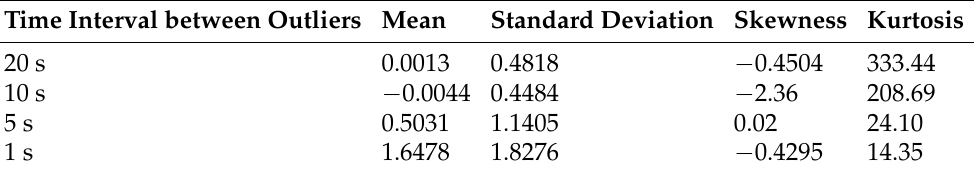
Statistical measurements of the tracking error of the controlled system using the MSE criterion.